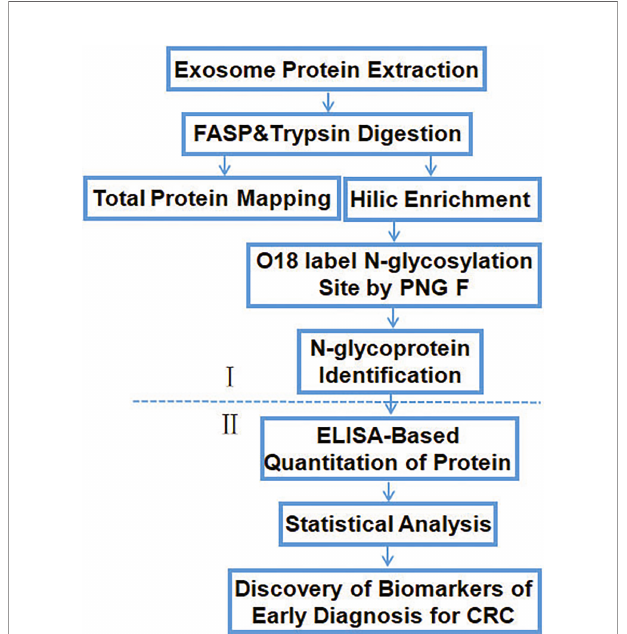
FIGURE 2 | Work fl ow of the identi fi cation and quanti fi cation of exosomal glycoproteins in healthy controls and patients with CRC.